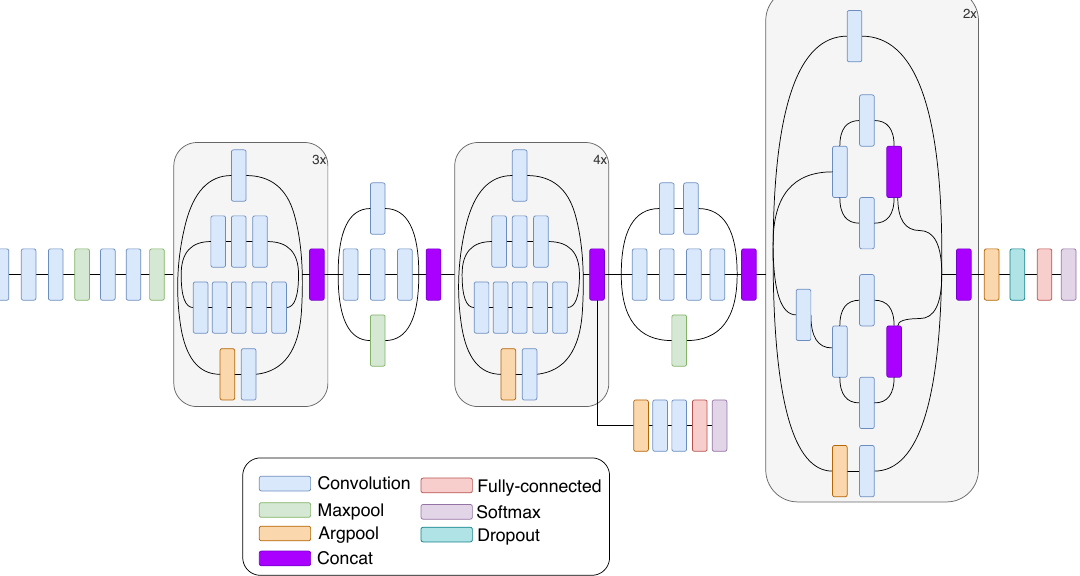
Figure 9. Inception architecture